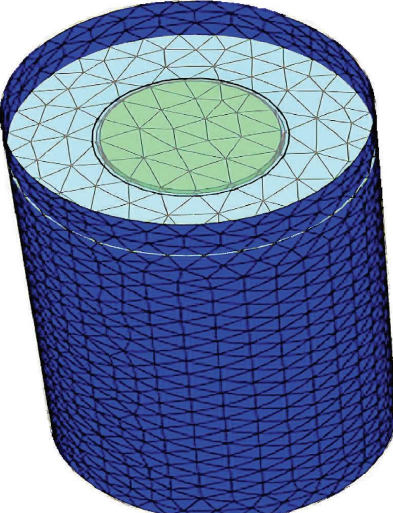
Figure 1: Schematic diagram of a soil bed with a single column modelled.